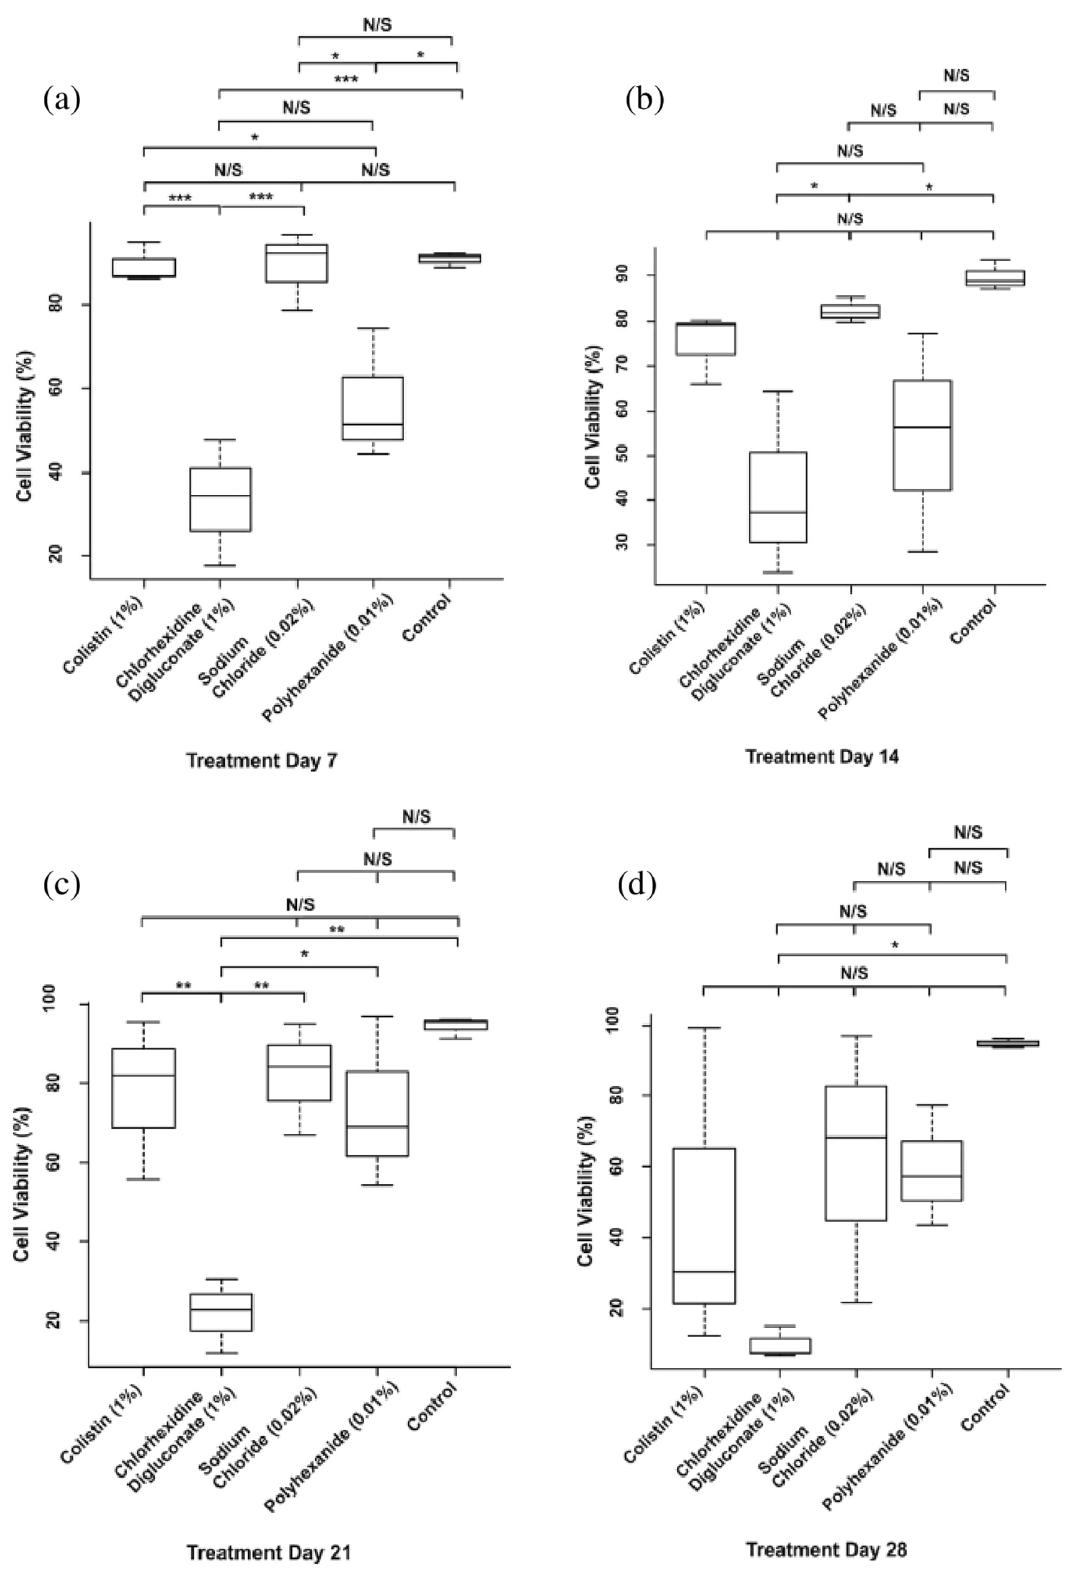
Figure 7. Statistical analysis of the days of treatment in the antiseptic/antibiotic viability (Table 1) treatment. Boxplot of cell viability percentage at ( a ) day 7, ( b ) day 14, ( c ) day 21, and ( d ) day 28 of treatment. N/S: no significant differences; * p ≤ 0.05; ** p ≤ 0.01; *** p ≤ 0.001. n = 3. The values of p ≤ 0.05 were considered statistically significant.